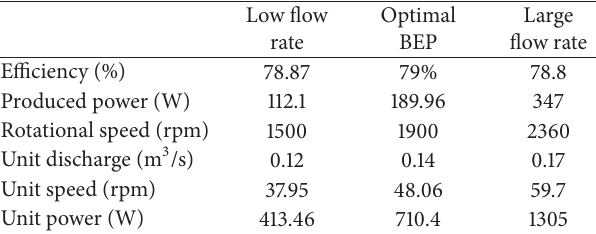
Table 3: Characteristics of the operating conditions.